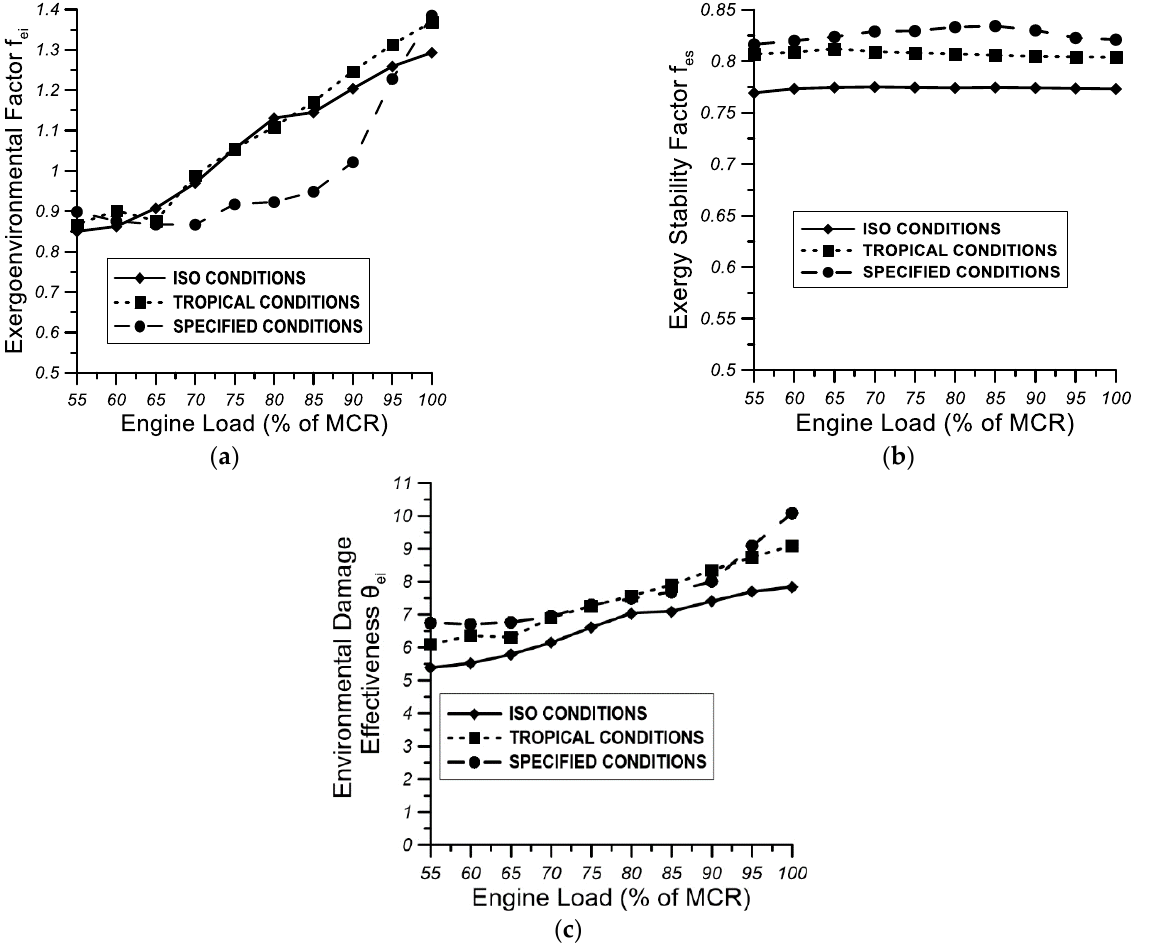
Figure 13. Variation of ( a ) exergo-environmental factor, ( b ) exergy stability factor, and ( c ) environ- mental damage effectiveness with engine load for ISO, tropical, and specified conditions.